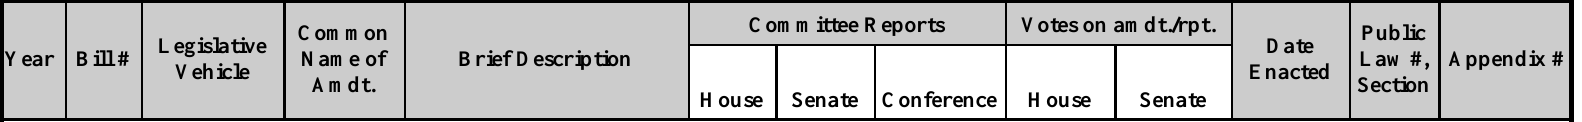
Table 2: Non-Funding Restrictions on Military